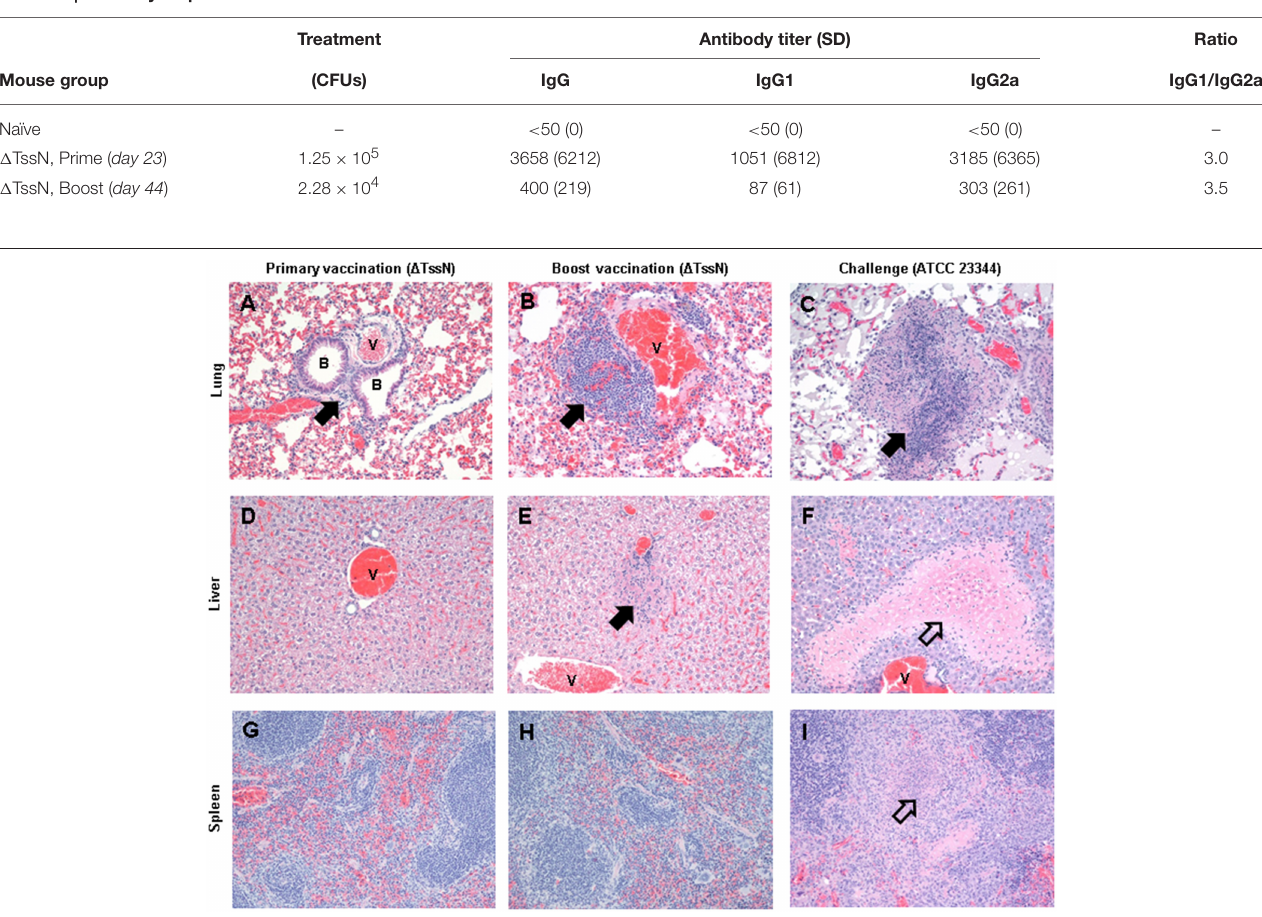
TABLE 2 | Antibody response to 1 TssN vaccination in BALB/c mice.